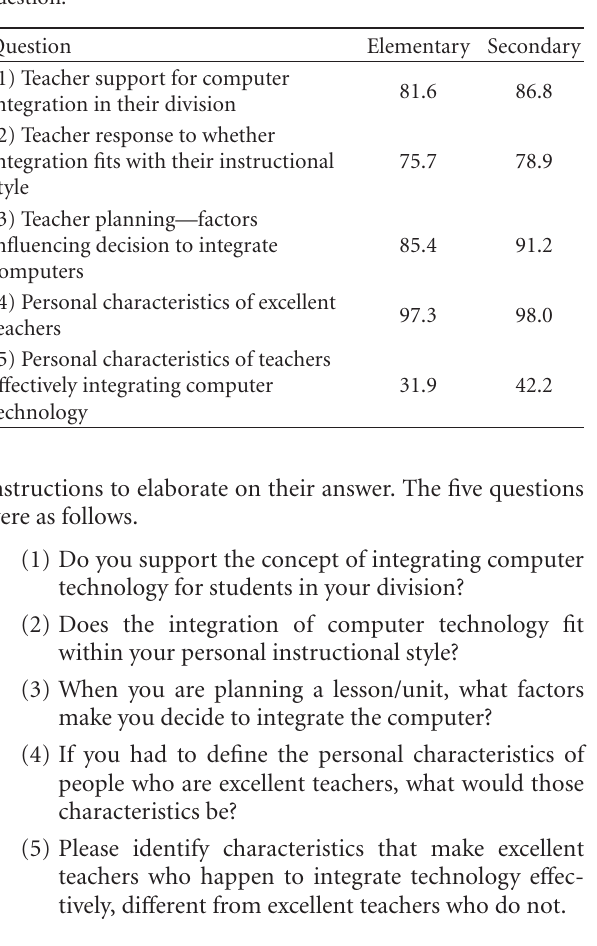
Table 1: Percent of participants responding to each qualitative